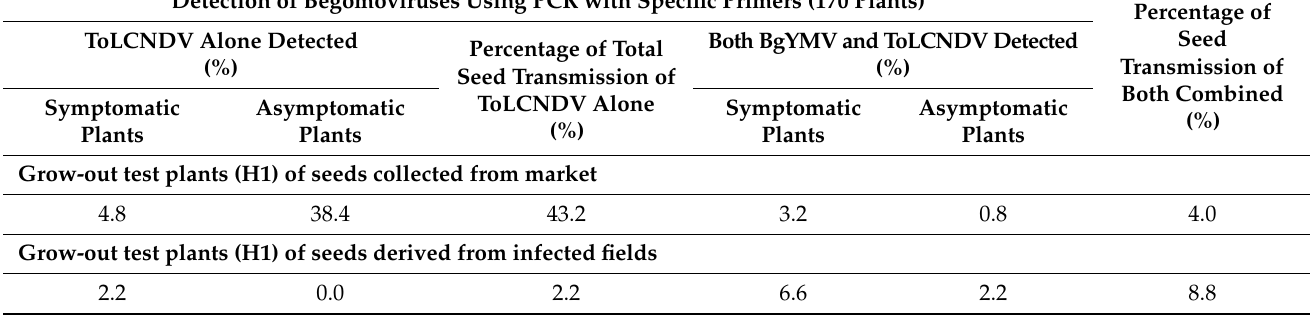
Table 4. Detection of begomoviruses in bitter gourd grow-out test plants (leaf samples) in microplot I. Detection of Begomoviruses Using PCR with Specific Primers (170